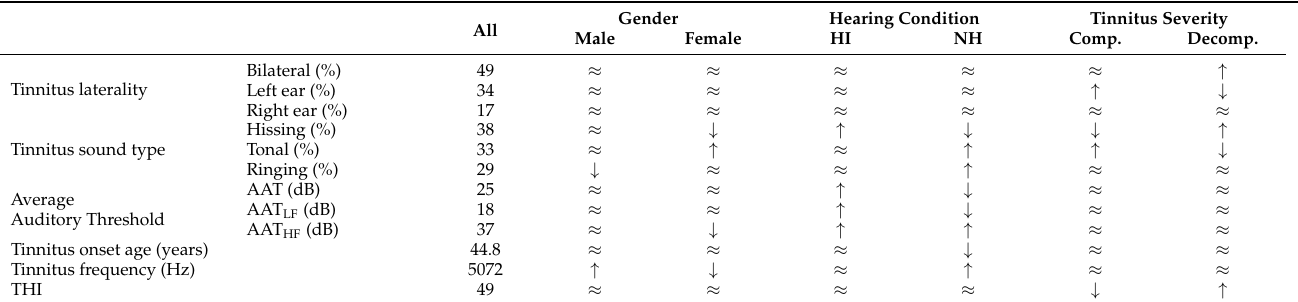
Table 6. Summary of the mean categorical and quantitative variables. Significantly higher and lower values are marked with symbols ↑ and ↓ . Comp. and decomp. stand for compensated and decompensated tinnitus, respectively. Gender Hearing Condition Tinnitus Severity All